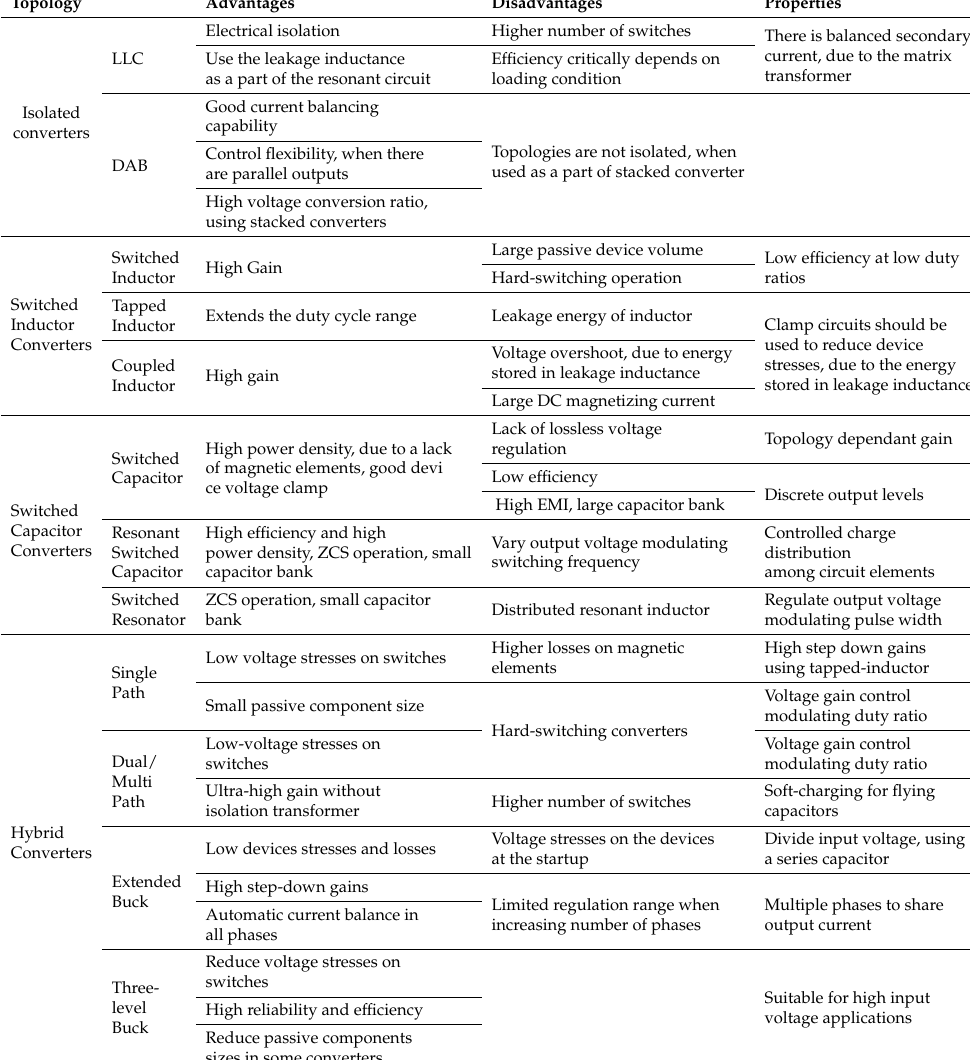
Table 1. Converter